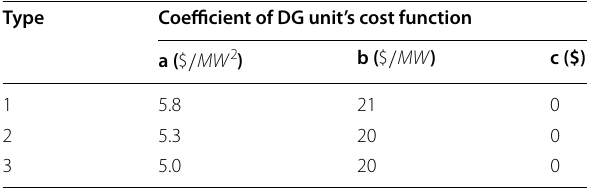
Table 3 DG units cost coefficients